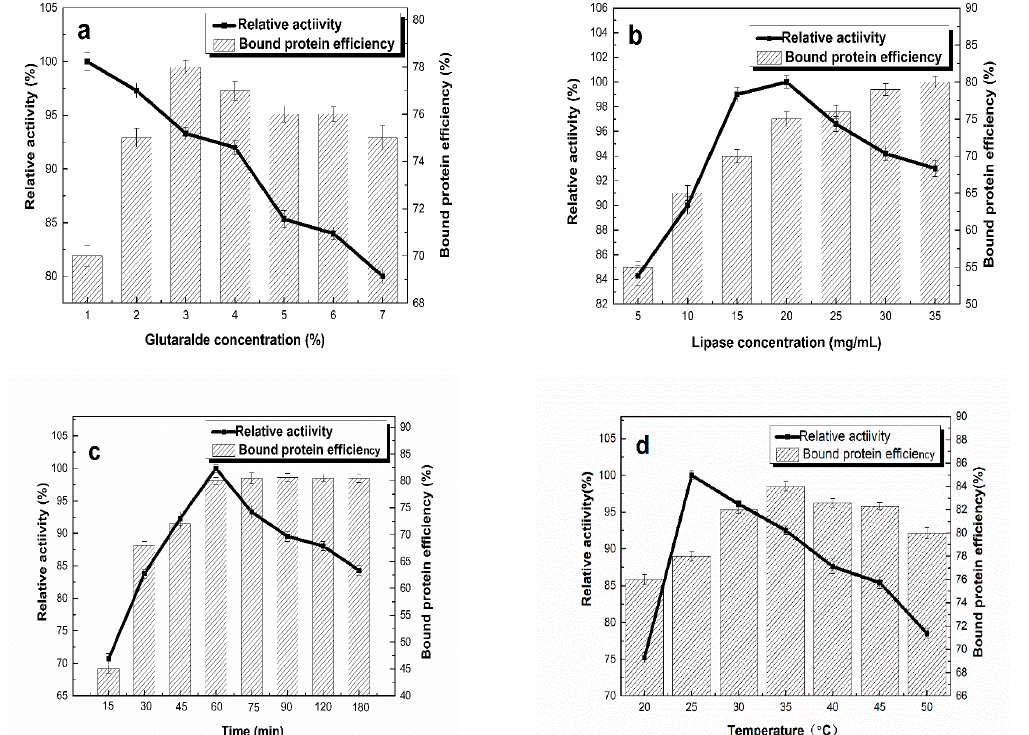
Figure 5. Effect of immobilization conditions on the relative activity and bound protein efficiency: ( a ) glutaraldehyde concentration, (conditions: lipase 10 mg/mL; temperature, 30 °C; time, 60 min); ( b ) lipase concentration, (glutaraldehyde 2%; temperature, 30 °C; time, 60 min); ( c ) time,